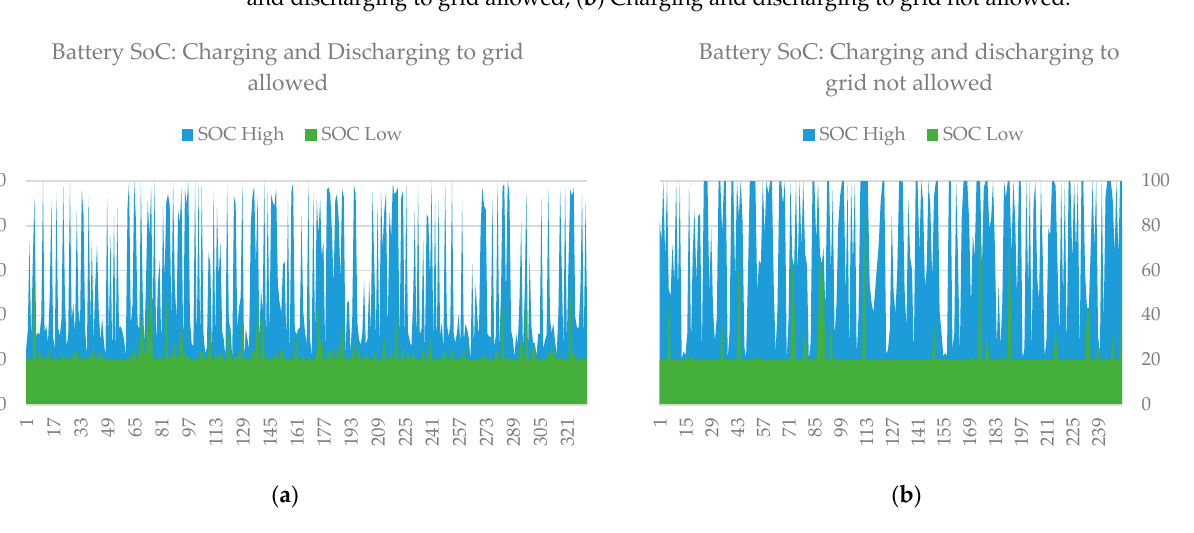
Figure A2. BESS SOC values at the end of each charge (SOC High) and discharge (SOC Low) cycle: ( a ) Charging and discharging to grid allowed; ( b ) Charging and discharging to grid not allowed.